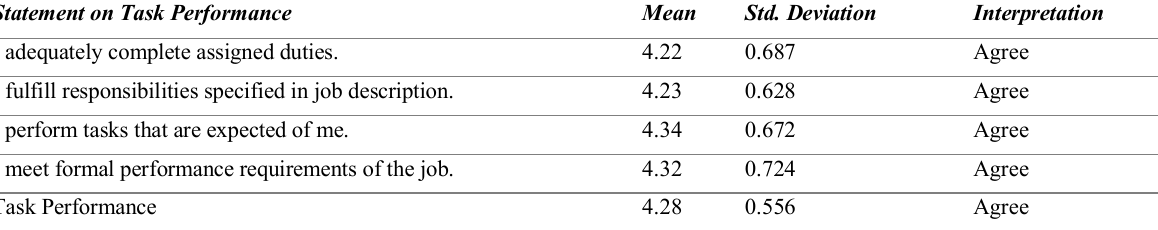
Table 6: Mean of statement on task